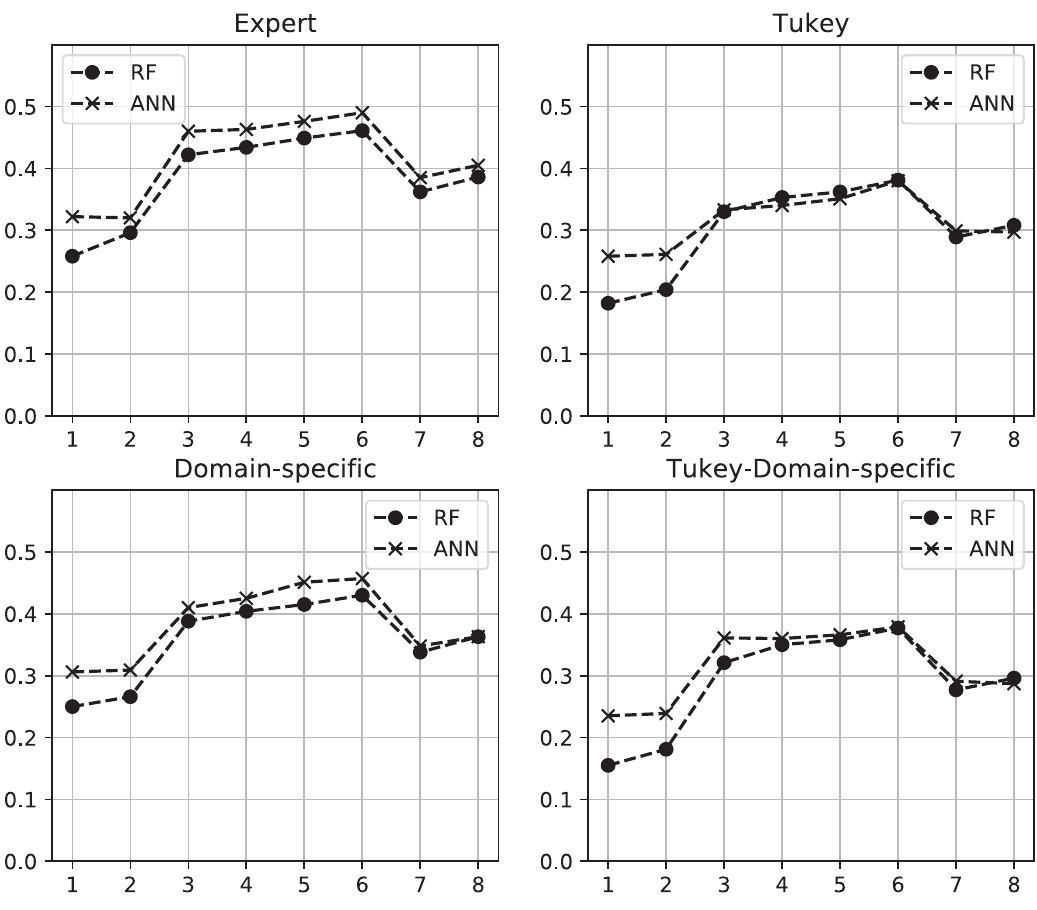
Figure 8. ¯ R 2 µ -values for each variable batch (VB 1-8 on the abscissa) and cleaning strategy. VB 1–2: Without scrap representation. VB 3–4: Steel plant scrap representation. VB 5-6: Visual scrap representation. VB 7–8: Density scrap representation. Table 8. The performance and meta data of the best models, and the meta data for the four cleaning strategies. The values in parentheses show the values from the ANN